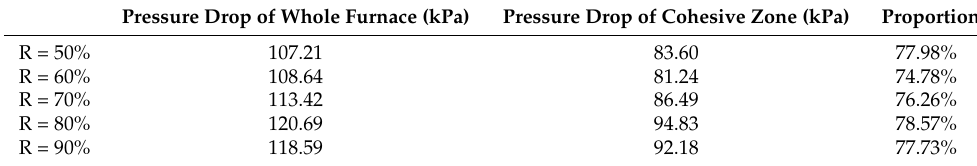
Figure 10. Pressure drop of the cohesive zone and the average pressure drop of one layer. R=50% R=60% R=70%